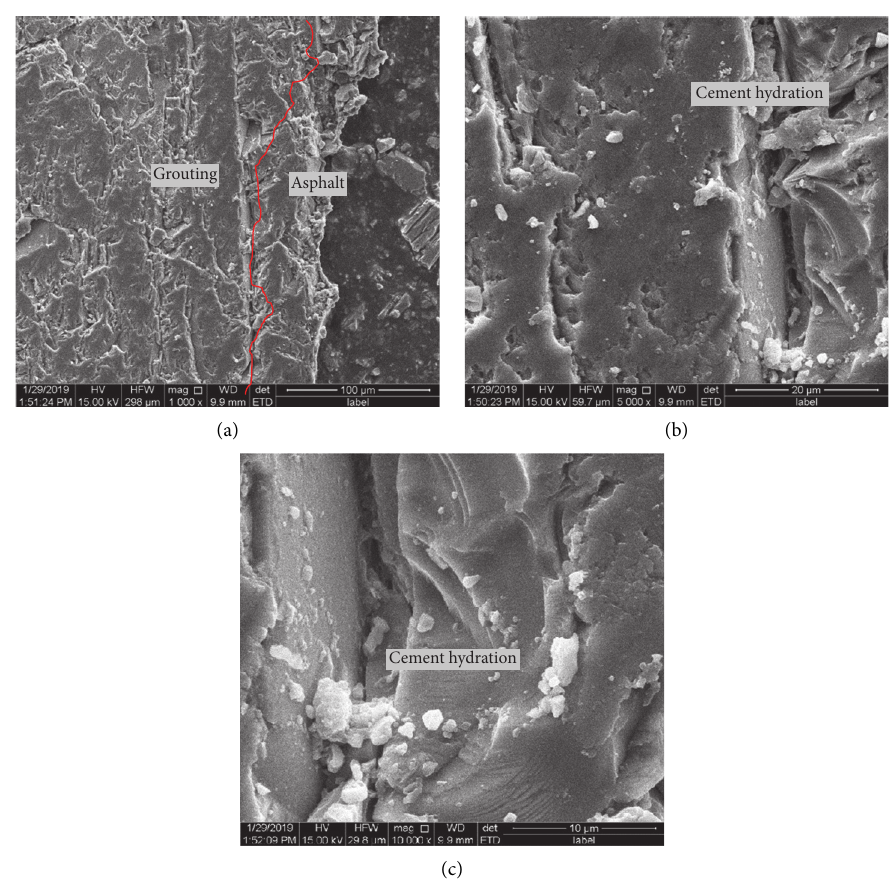
Figure 20: Morphology of SFP sample cured for 7 days. (a) Scale bar � 100 μ m. (b) Scale bar � 20 μ m. (c) Scale bar � 10 μ m.